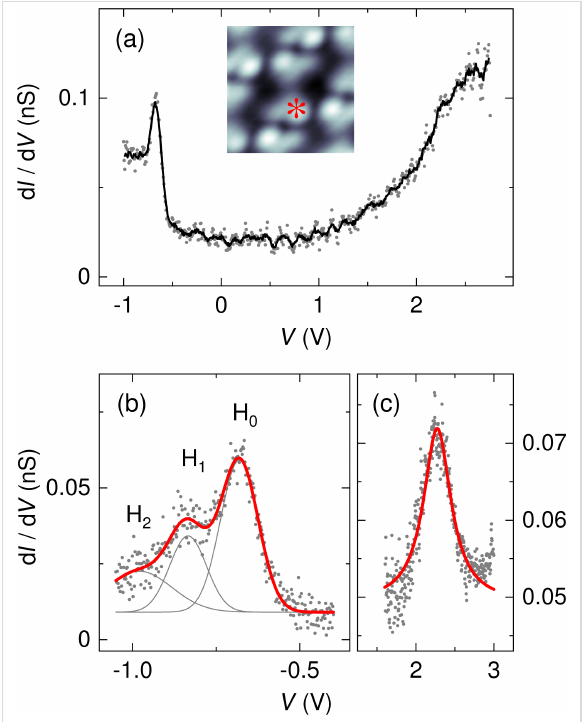
Figure 5: (a) Spectrum of d I /d V (dots) recorded above a C 42 H 28 phe- nyl group on Au(111) with the spectroscopic signature of the HOMO appearing at approx. − 0.67 V (feedback loop parameters: − 1 V, 50 pA). The solid line represents smoothed data. Inset: STM image of a single C 42 H 28 molecule on Au(111) ( − 0.65 V, 100 nA, 2 × 2 nm 2 ) with the asterisk marking the position of spectroscopy. (b) Close-up view of the HOMO (H 0 ) vibronic fine structure (feedback loop parame- ters: − 1 V, 50 pA). The presented data (dots) are normalized [38]. Vibronic side bands are labeled H 1 and H 2 . The thick solid line repre- sents a fit of three Lorentzian line shapes (thin gray lines) and a con- stant background to the data. (c) Normalized d I /d V data (dots) showing a peaked unoccupied molecular orbital at approx. 2.3 V (feedback loop parameters: 3 V, 50 pA). The solid line represents the fit of a Lorentzian line shape and a constant background to the